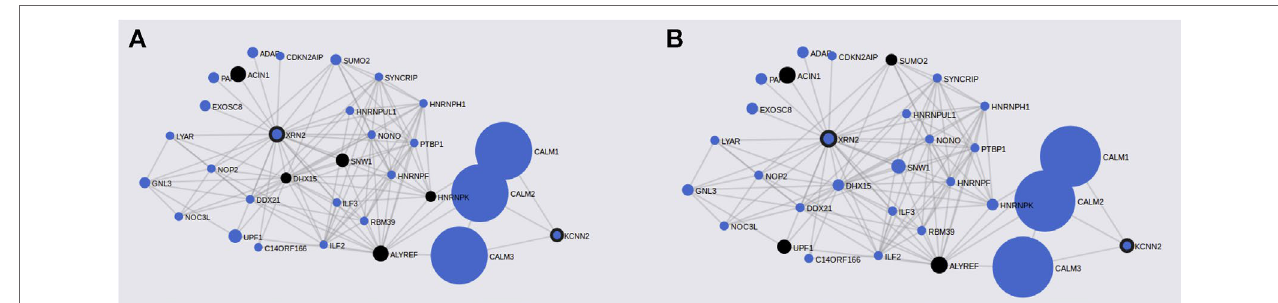
FIGURE 2 | ASD gene networks constructed with PASCAL associated genes and its FunCoup interactors. Node sizes scale to emphasize gene importance in the whole network, while participating nodes for each KEGG pathway are marked in black: (A) cAMP signaling pathway; (B) RNA